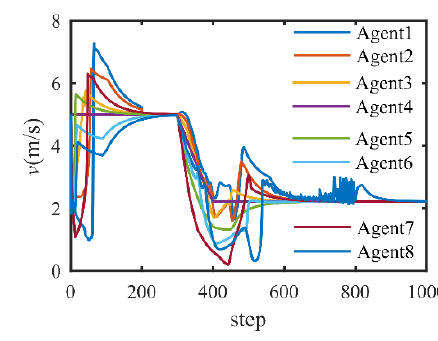
Figure 13. Track with bearings only (test 3).